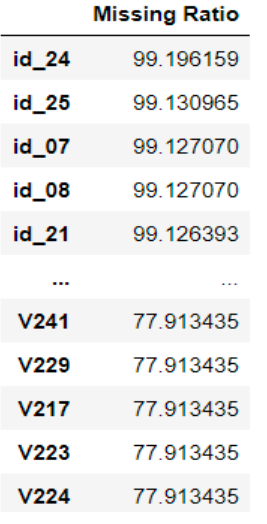
Figure 2. Missing ratio for each column in the dataset.